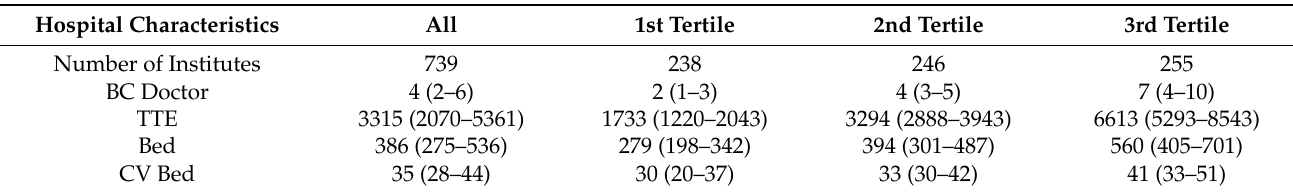
Table 1. Baseline hospital